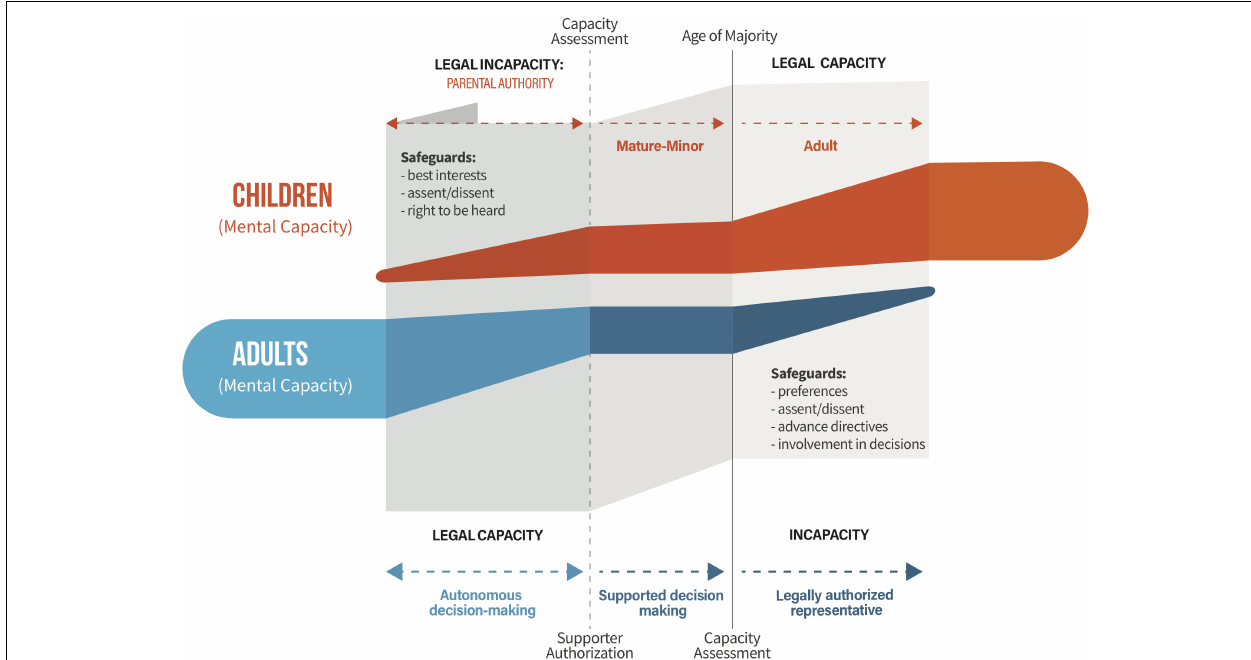
FIGURE 1 | The opposing decision-making capacity trajectories of children and decisionally vulnerable adults in research: ethical and legal considerations. The mental capacity of children normally develops with age. Parents generally have legal authority over their children, who acquire legal capacity at the age of majority. Children may acquire legal capacity at an earlier age for certain types of decisions under mature-minor exceptions. Adults may experience a loss of or fluctuating mental capacity over time. Their legal capacity is generally presumed, until a capacity assessment demonstrates they are no longer able to make certain types of decisions. Under supported decision-making regimes, carers help adults to make their own decisions. For adults who lack legal capacity, LARs make decisions on their behalf. LARs typically have obligations to consult the individual, and to respect certain criteria (e.g., best interests, previous and current wishes, values and beliefs). Note that this Figure constitutes high level generalizations across populations and regulatory frameworks. Refer to Box 1 for